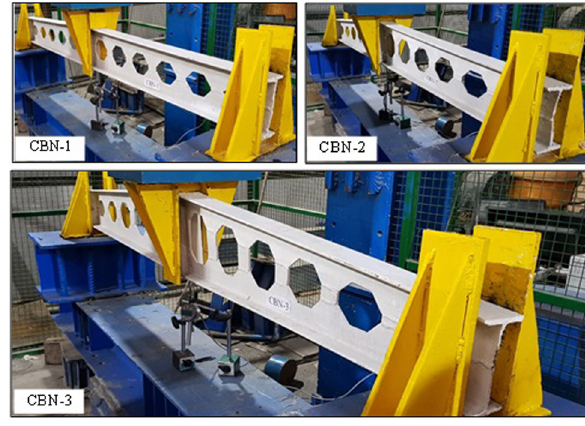
Figure 10: Sequence of Vierendeel mechanism.